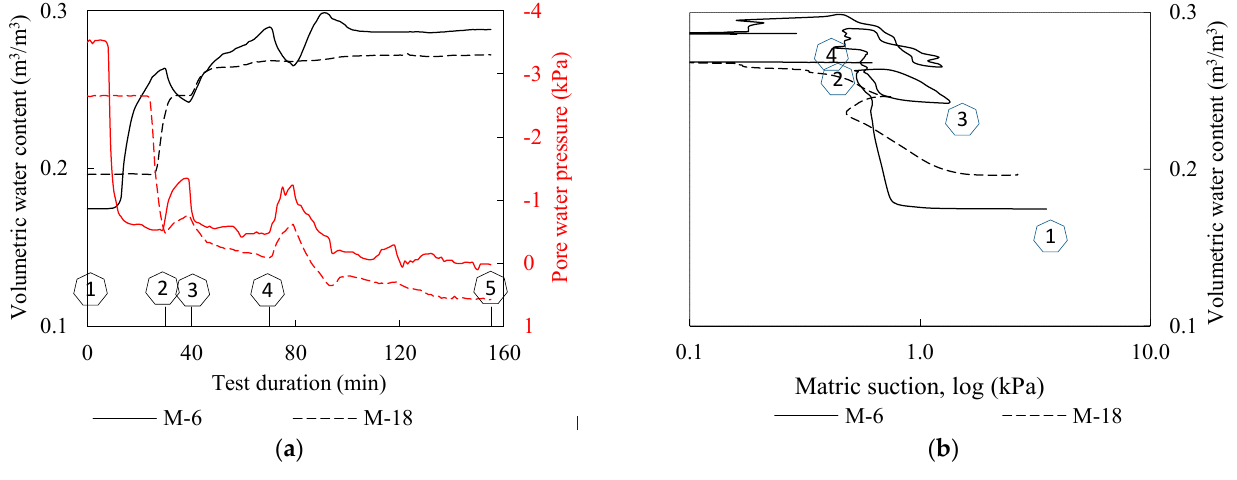
Figure 12. Hydraulic monitoring data from the test considered in Example 2 for points at 6 (M-6, continuous lines) and 18 cm depth (M-18, dashed lines) on the M measurement profile: ( a ) VWC and pore water pressure changes during the test; and ( b ) data in the logarithmic ( u a -u w ) vs. VWC Figure 11. The SK15 slope model considered in Example 2 at the start of the test ( a ); 18 min ( b ); and plane. 159 min after the start of the test ( c ).